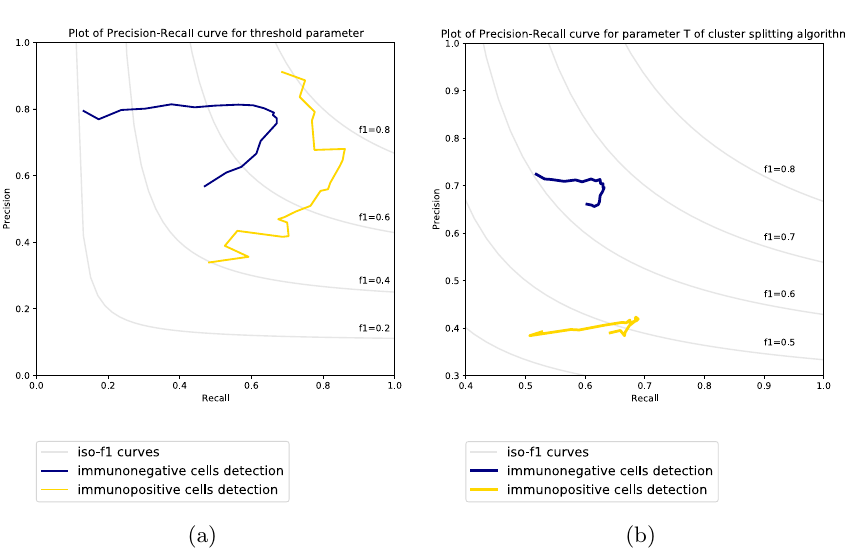
Figure 6. Precision-recall curves for CHISEL’s parameter tuning. Isolines indicate the regions of different F1 scores. (left) The curve is generated by varying the value of threshold parameter of the segmentation algorithm. (right) The curve is generated by varying the value of T parameter of the cluster splitting